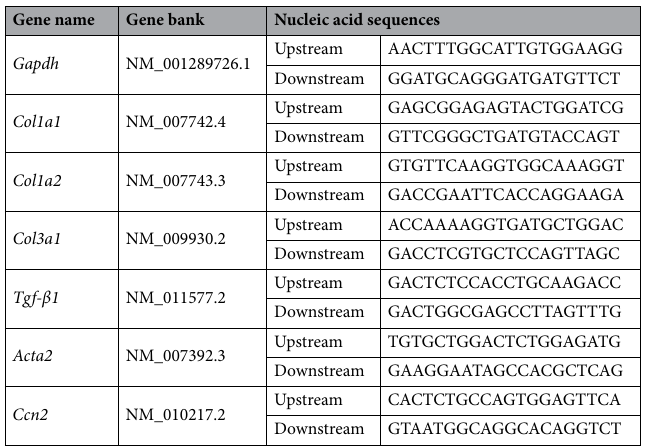
Table 1. Polymerase chain reaction primer sequences. Gapdh , glyceraldehyde-3-phosphate dehydrogenase; Col1a1 , collagen type IA1; Col1a2 , collagen type IA2; Col3a1 , collagen type IIIA1; Tgf-β1 , transforming growth factor beta 1; Acta2 , actin alpha 2; Ccn2 , cellular communication network factor